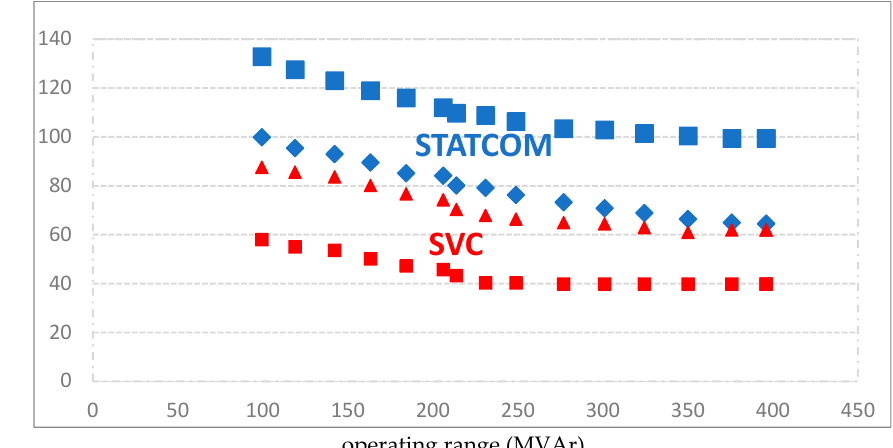
Figure 19. Cost of the operation range for different D-FACTS devices. Reproduced from [14].